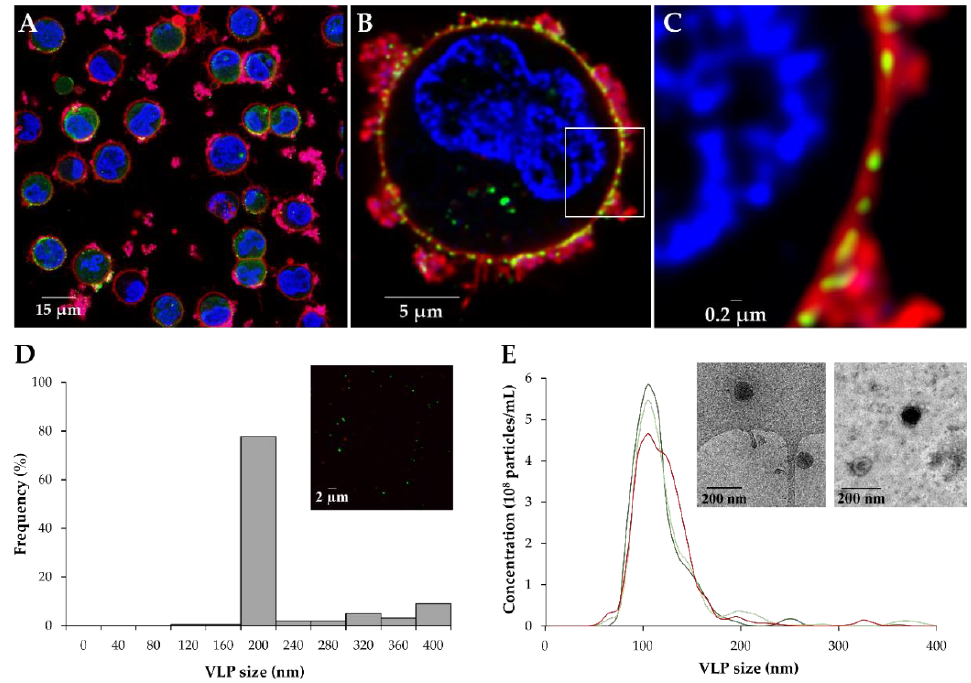
Figure 5. Assessment of VLP production in HEK293 cells and analysis of the VLPs produced at 48 hpt. ( A ) SRFM images of transduced HEK293 cells at 48 hpt. Cell nuclei were stained with Hoechst (blue), and the cytoplasmatic membrane was stained with CellMask TM (red). ( B ) Deconvoluted image of a transduced HEK293 cell producing Gag-eGFP VLPs. ( C ) Zoom-in of the white section. ( D ) Analysis of VLP size by SRFM. Upper right: SRFM image of VLPs. ( E ) Analysis of VLP size using NTA. Upper right: cryo-TEM (left) and NS-TEM (right) images of